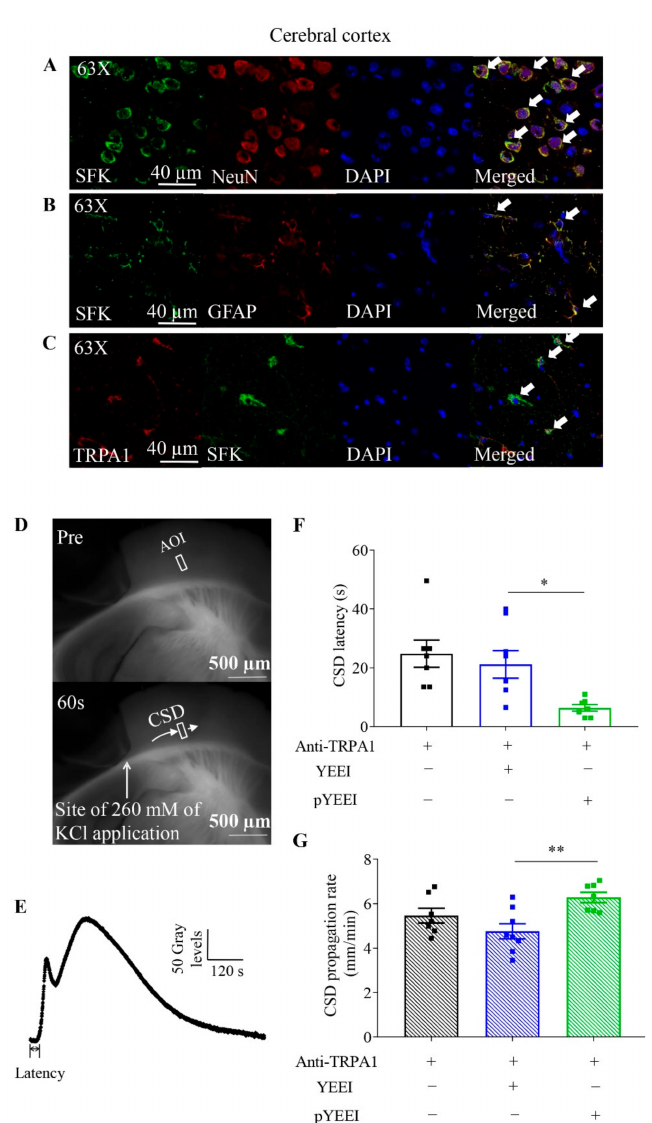
Figure 1. Co-localization of TRPA1 and SFKs, and effects of pYEEI, the SFKs activator, on the anti- TRPA1 antibody-reduced cortical susceptibility to CSD in the mouse brain slice. ( A , B ) Representative images of expression of SFKs in neurons and astrocytes of mouse cerebral cortices. ( C ) Representative images of co-localization of TRPA1 and SFKs in mouse cerebral cortices. Staining with DAPI indicated nucleus as shown in blue; staining with the anti-TRPA1 antibody was shown in red; staining with the anti-NeuN antibody indicated neurons and staining with the anti-GFAP antibody indicated astrocytes as shown in green. Double immune-labeling showed expression of SFKs in neurons and astrocytes of mouse cerebral cortices or co-expression of TRPA1 and SFKs in mouse cerebral cortices (white arrows, n = 3 per group). ( D ) Representative images of the coronal slice of mouse brain before (upper) and after (lower) CSD induced by ejection of 260 mM KCl in the cerebral cortical region. The same area of interest (AOI) along CSD wave front (pointed by the short arrow) was selected and used for all images. ( E ) The averaged gray level within the AOI was plotted against time to generate the CSD curve. ( F , G ) Effects of 0.015 µ M anti-TRPA1 antibody (Anti-TRPA1) ( n = 7), 0.015 µ M anti-TRPA1 antibody + 0.1 µ M pYEEI ( n = 7), or 0.015 µ M anti-TRPA1 antibody + 0.1 µ M YEEI ( n = 8) on CSD latency (seconds, s) and CSD propagation rate (mm/minute, mm/min) in mouse brain slices. Group data were presented as mean ± SEM. Two-tailed unpaired t -test was used for comparison between pYEEI and YEEI group in the presence of anti-TRPA1 antibody. Significance differences were shown as * p < 0.05, ** p <